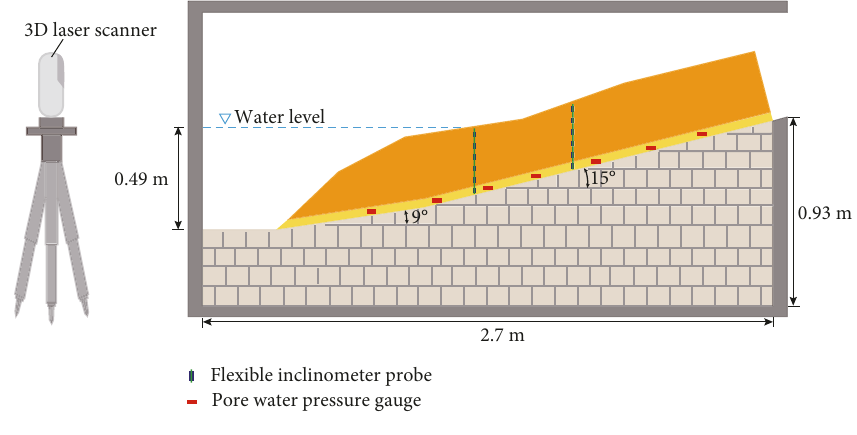
Figure 4: Layout of the physical model. Table 1: Similar ratio of principal parameters ( n = 40 ).